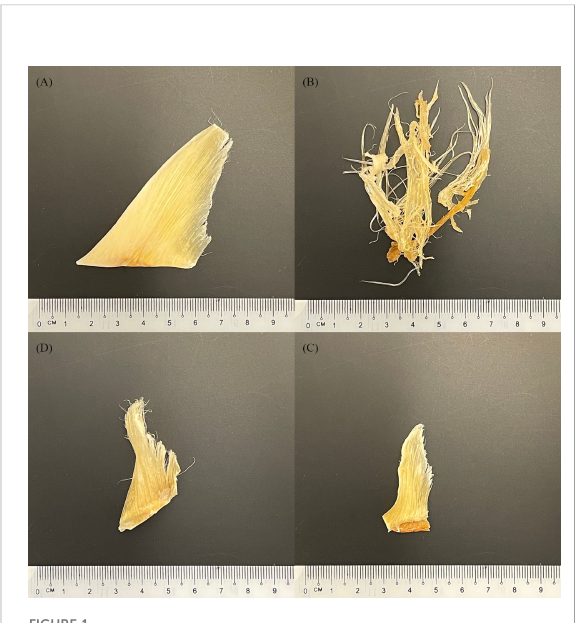
FIGURE 1 Selection of purchased dried shark fi ns (Barcoded as: (A, B) Sphyrna mokarran , (C, D) Rhizoprionodon oligolinx